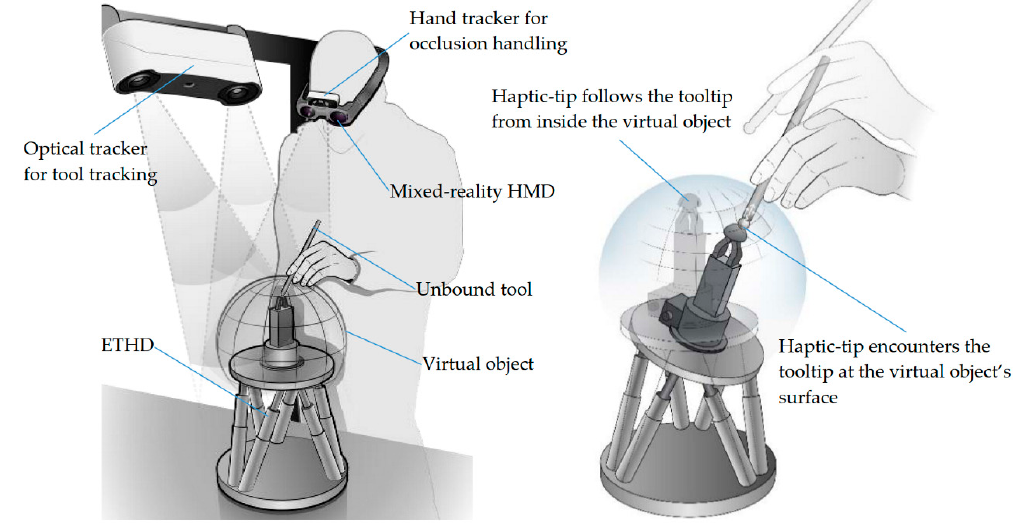
Figure 1. The proposed visuo-haptic mixed reality (VHMR) concept. ETHD, encountered-type haptic display; HMD, head-mounted display.